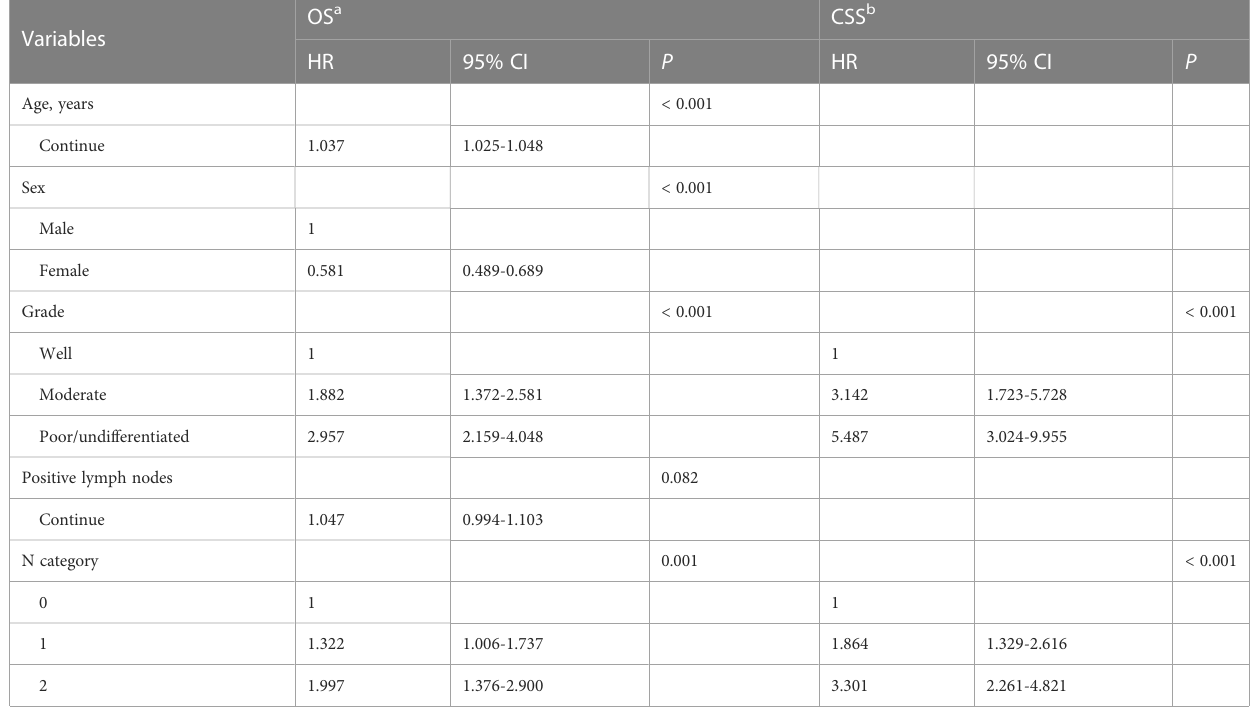
TABLE 3 LASSO-penalized multivariable Cox analysis of the T2b and T3-Add NSCLC patients after PSM.